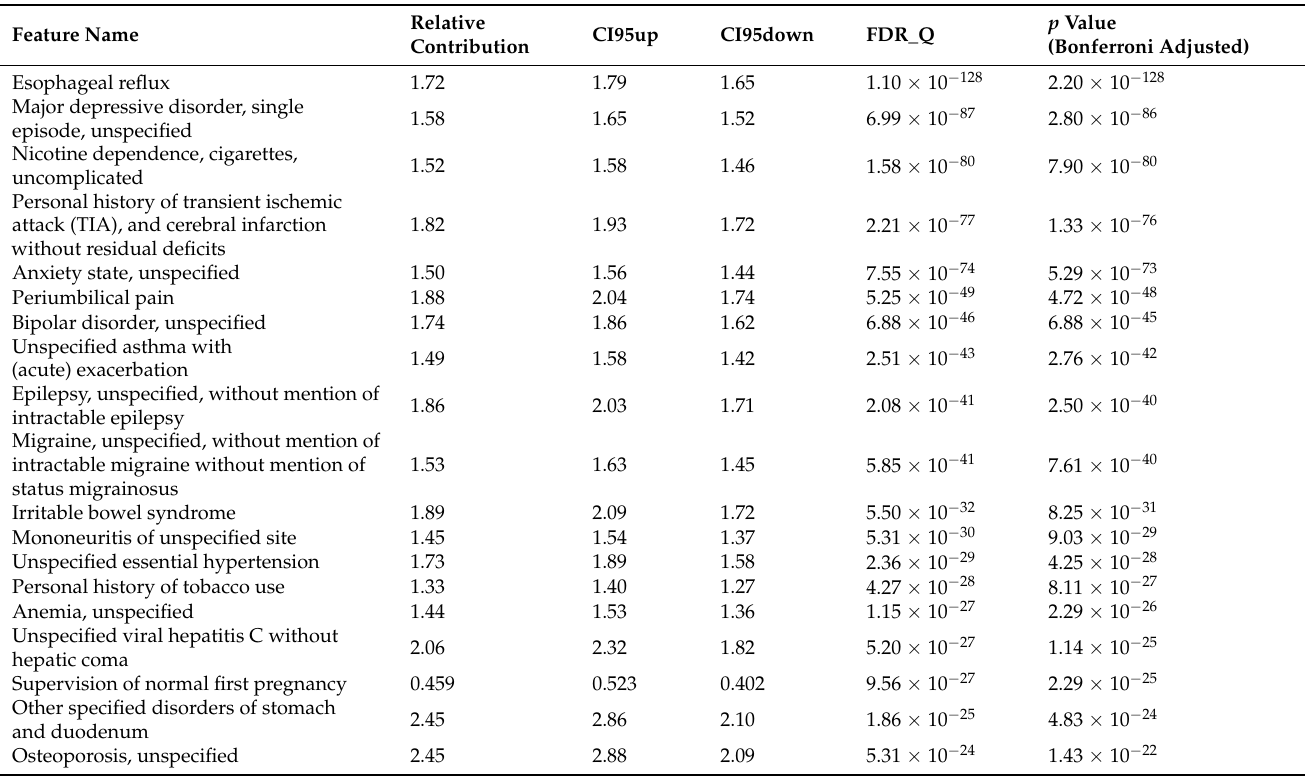
Table 4. Important diagnosis results identified by perturbation-based contribution analysis for SRE